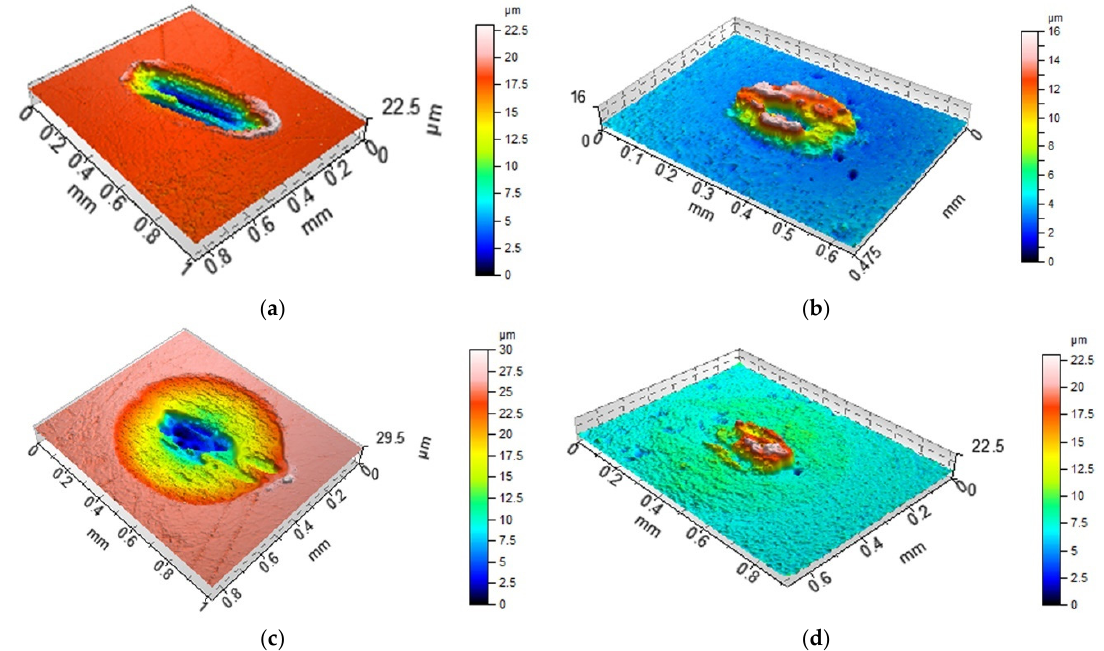
Figure 9. Isometric views of disc L ( a , c ) and co-acted balls ( b , d ) after tests A ( a , b ) and B ( c , d ).